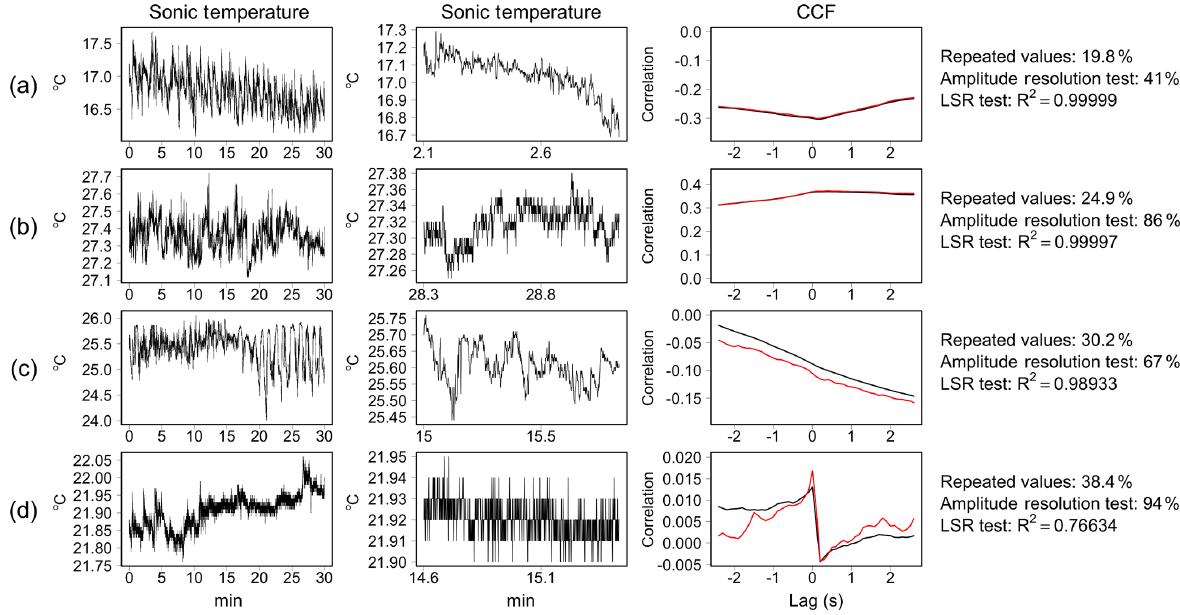
Figure 4. Comparison of low-signal-resolution (LSR) test and amplitude resolution test by VM97 on observed data collected at the SE-Nor site. Sonic temperature time series collected in 30min (left panels) and in a shorter temporal window of length equal to 1000 time steps (middle panels). The right panels show the cross-correlation function (CCF) between w -scalar time series with original data (black line) and after removal of repeated values (red line). The percentage of repeated consecutive values, the test statistics of the amplitude resolution and LSR tests are reported on the right-hand